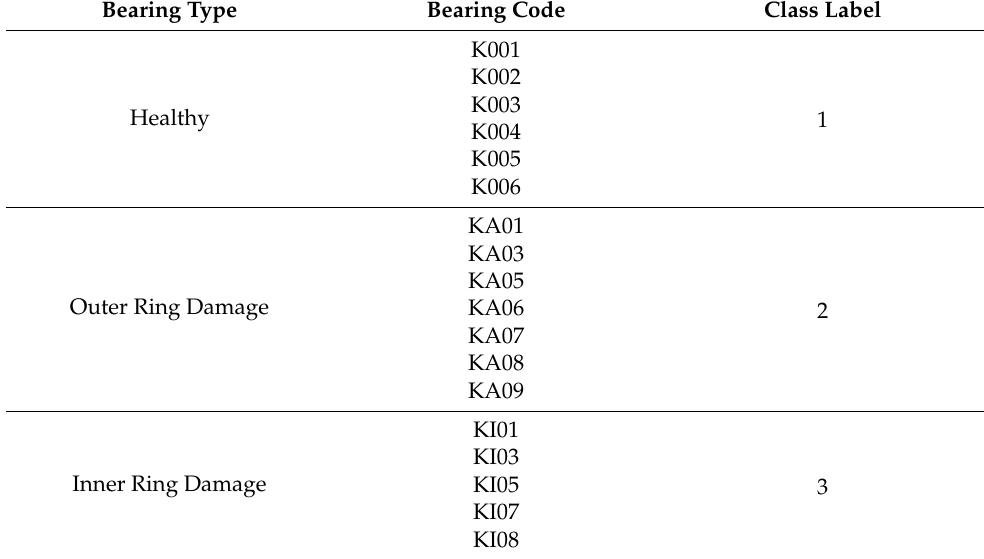
Table 2. Bearing data arrangement.